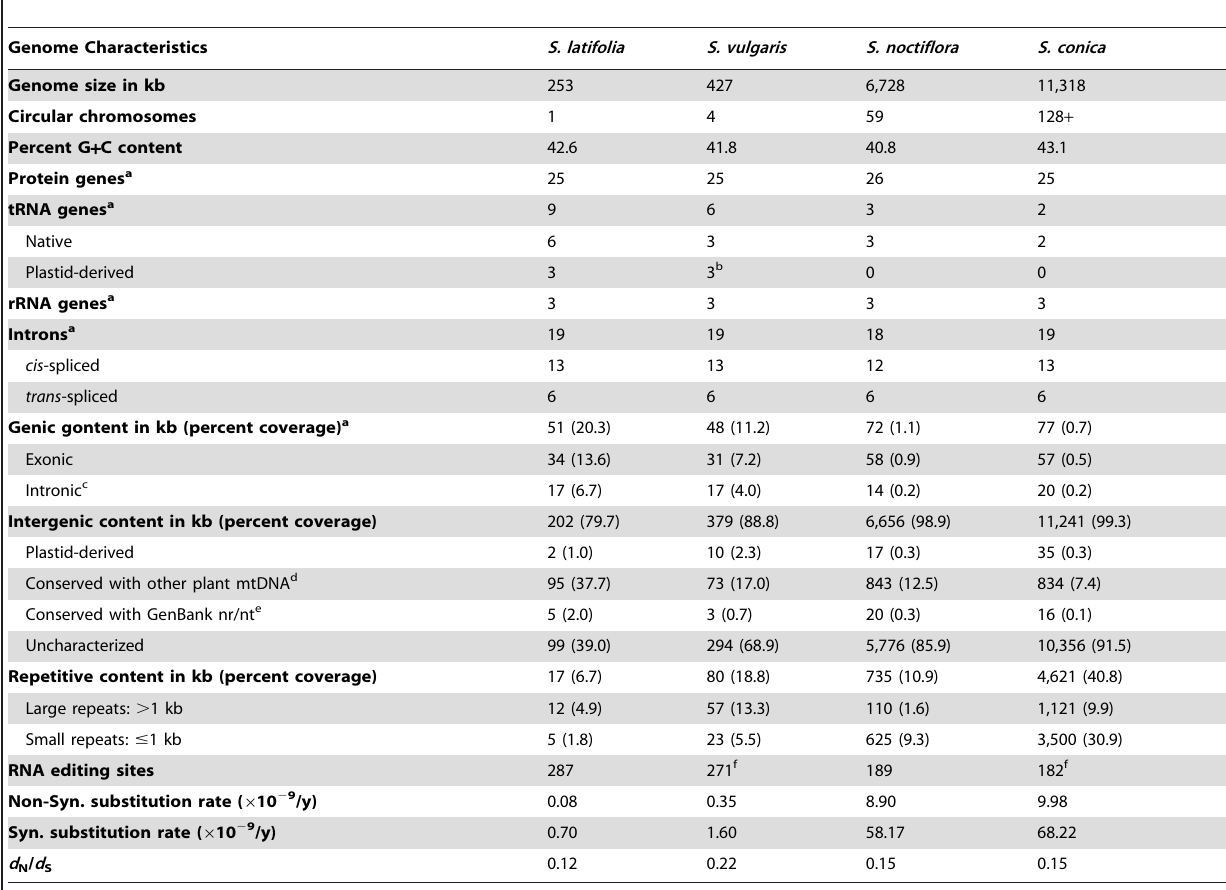
Table 1. Summary of four Silene mitochondrial